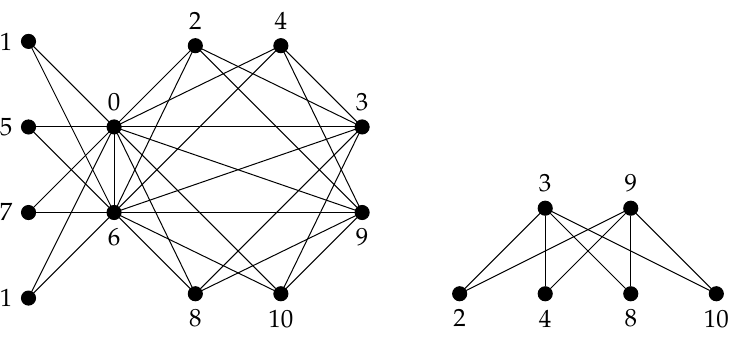
Figure 9. ( left ) T I ( Γ ( R )) and ( right ) Γ I ( R ) , when R = Z 12 and I = ( 6 )